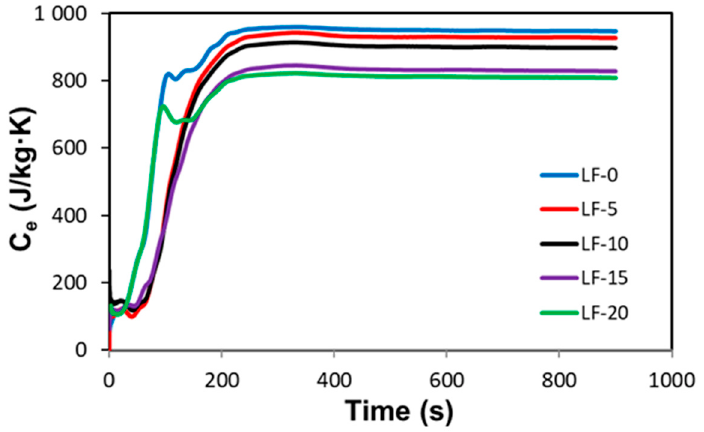
Figure 7. Representative curves of specific heat capacity C e vs. time measured by MDSC for each mortar composition.